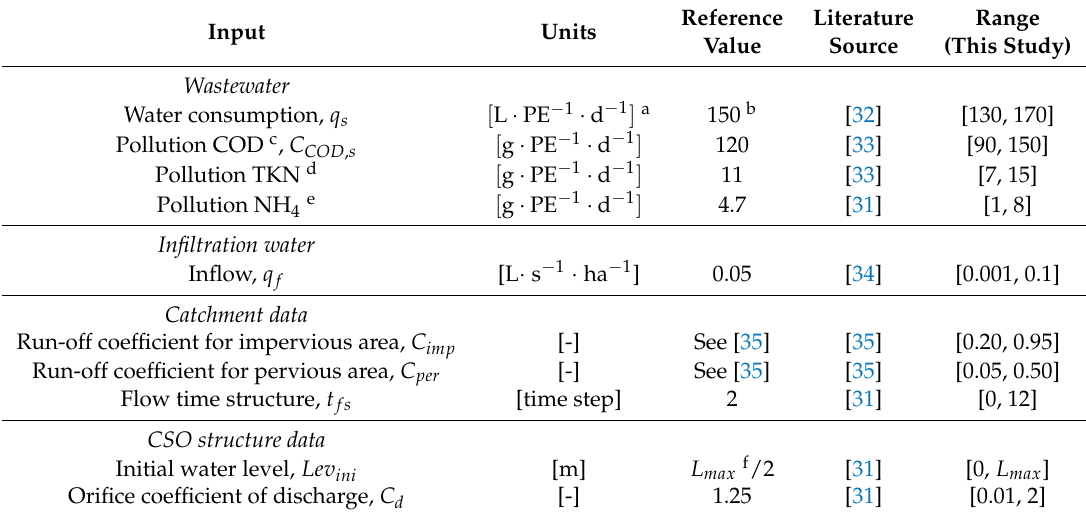
Table 3. Default values for input data of EmiStat R